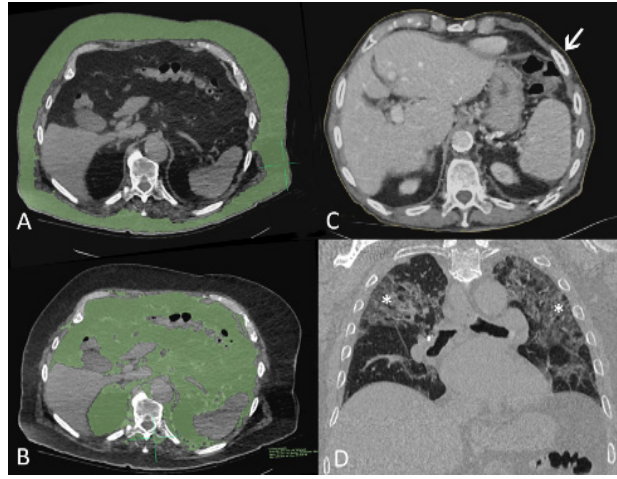
Figure 1. Computed tomography (CT) images of three patients with COVID-19 pneumonia. ( A , B ), axial images of 89-year-old man, soft tissue window setting. The first slice caudal to the pleural recesses shows overlay segmented parietal ( A ) and visceral ( B ) fat in green. ( C ) axial image of 93-year-old man, soft tissue window setting. Fine yellow line (arrow) delineates body circumference on the first slice caudal to pleural recesses. ( D ) Coronal-oblique reconstructed image of 86-year-old man in lung window setting shows stage 3 lung infiltrates with ground glass opacities, intralobular septal thickening, and parenchymal bands (asterisks).